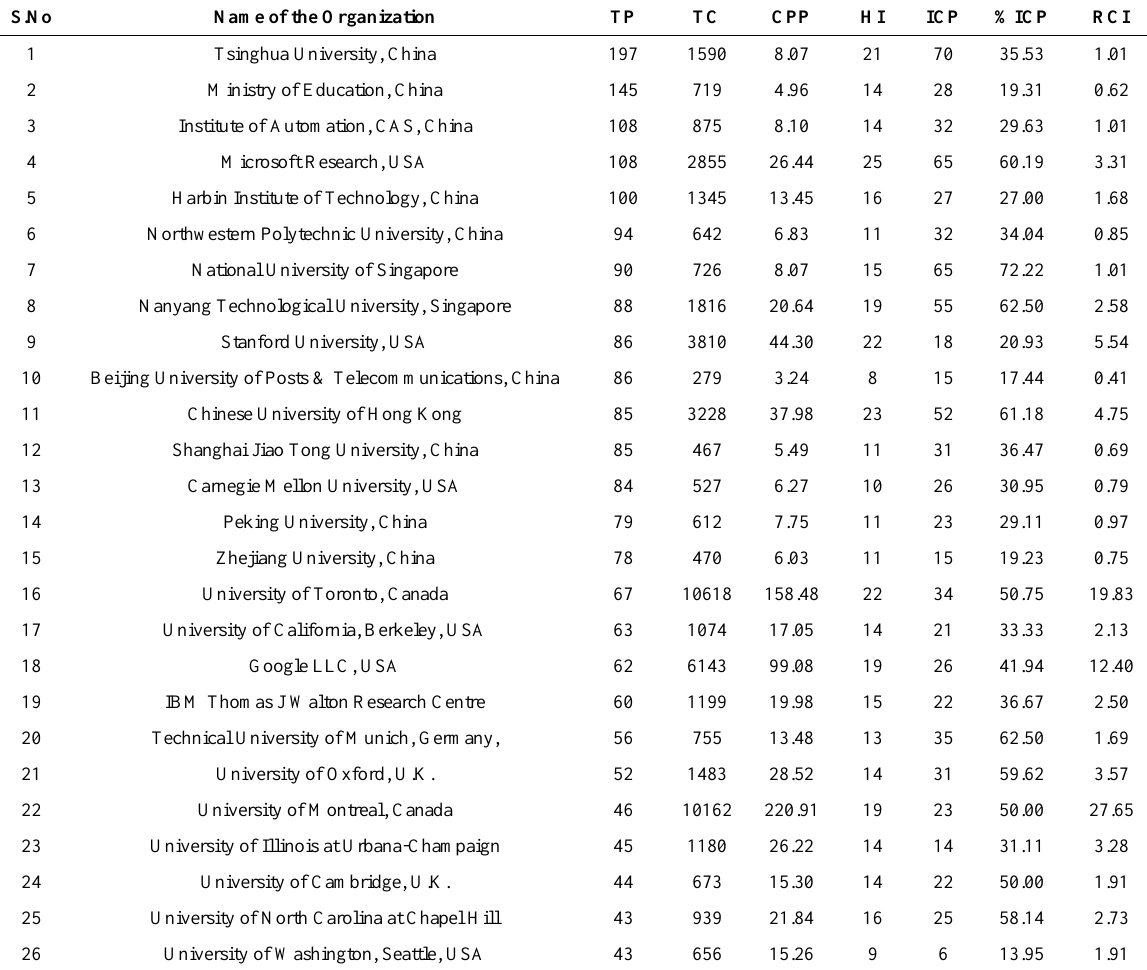
Table 4. Scientometric profile of top 15 most productive global organizations and 15 top organizations in relative citation index on deep learning during